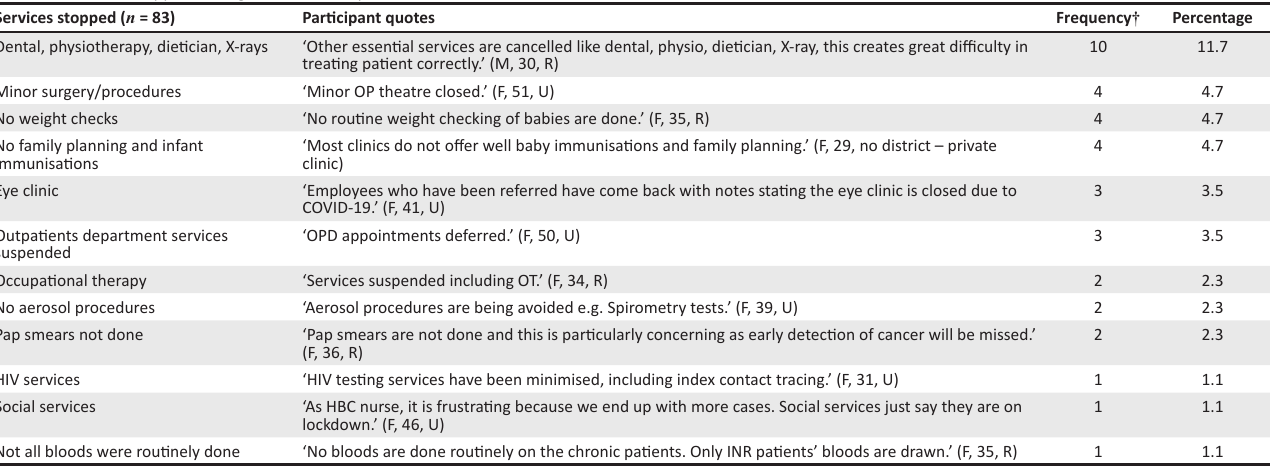
TABLE 3: Services stopped during the COVID-19 pandemic. Services stopped ( n = 83)